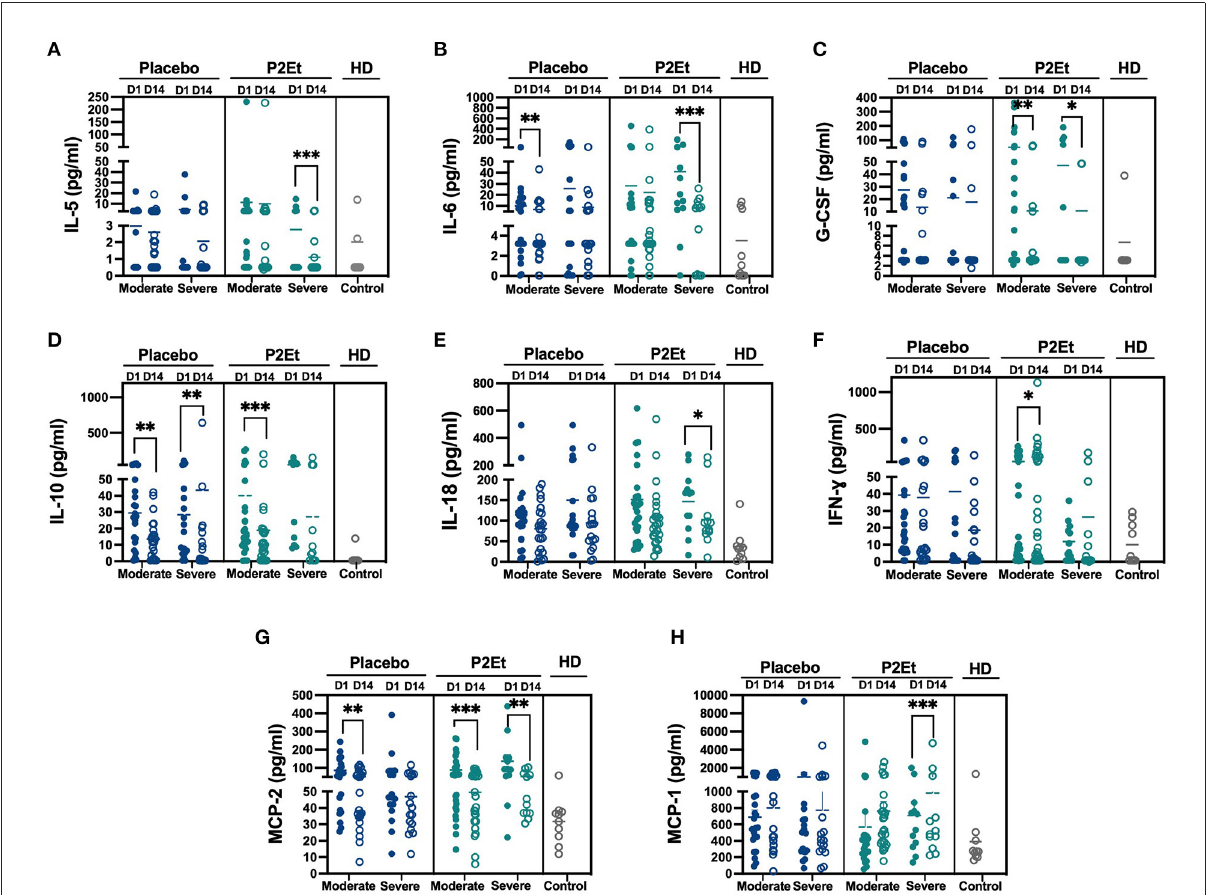
FIGURE3 P2Et treatment modulate of inflammatory response in COVID-19 patients. Samples from placebo, P2Et and Healthy donors (HD) groups were analyzed by Milliplex to identify the quantity of cytokines present in the serum. (A) IL-5, (B) IL-6, (C) G.CSF, (D) IL-10, (E) . IL-18, (F) IFN- γ , (G) MCP-2, and (H) MCP-1 cytokines. Each dot represent one human sample. The p values between placebo and P2Et group or within groups were calculated using a Wilconxon test. * p < 0.05, ** p < 0.01, *** p <